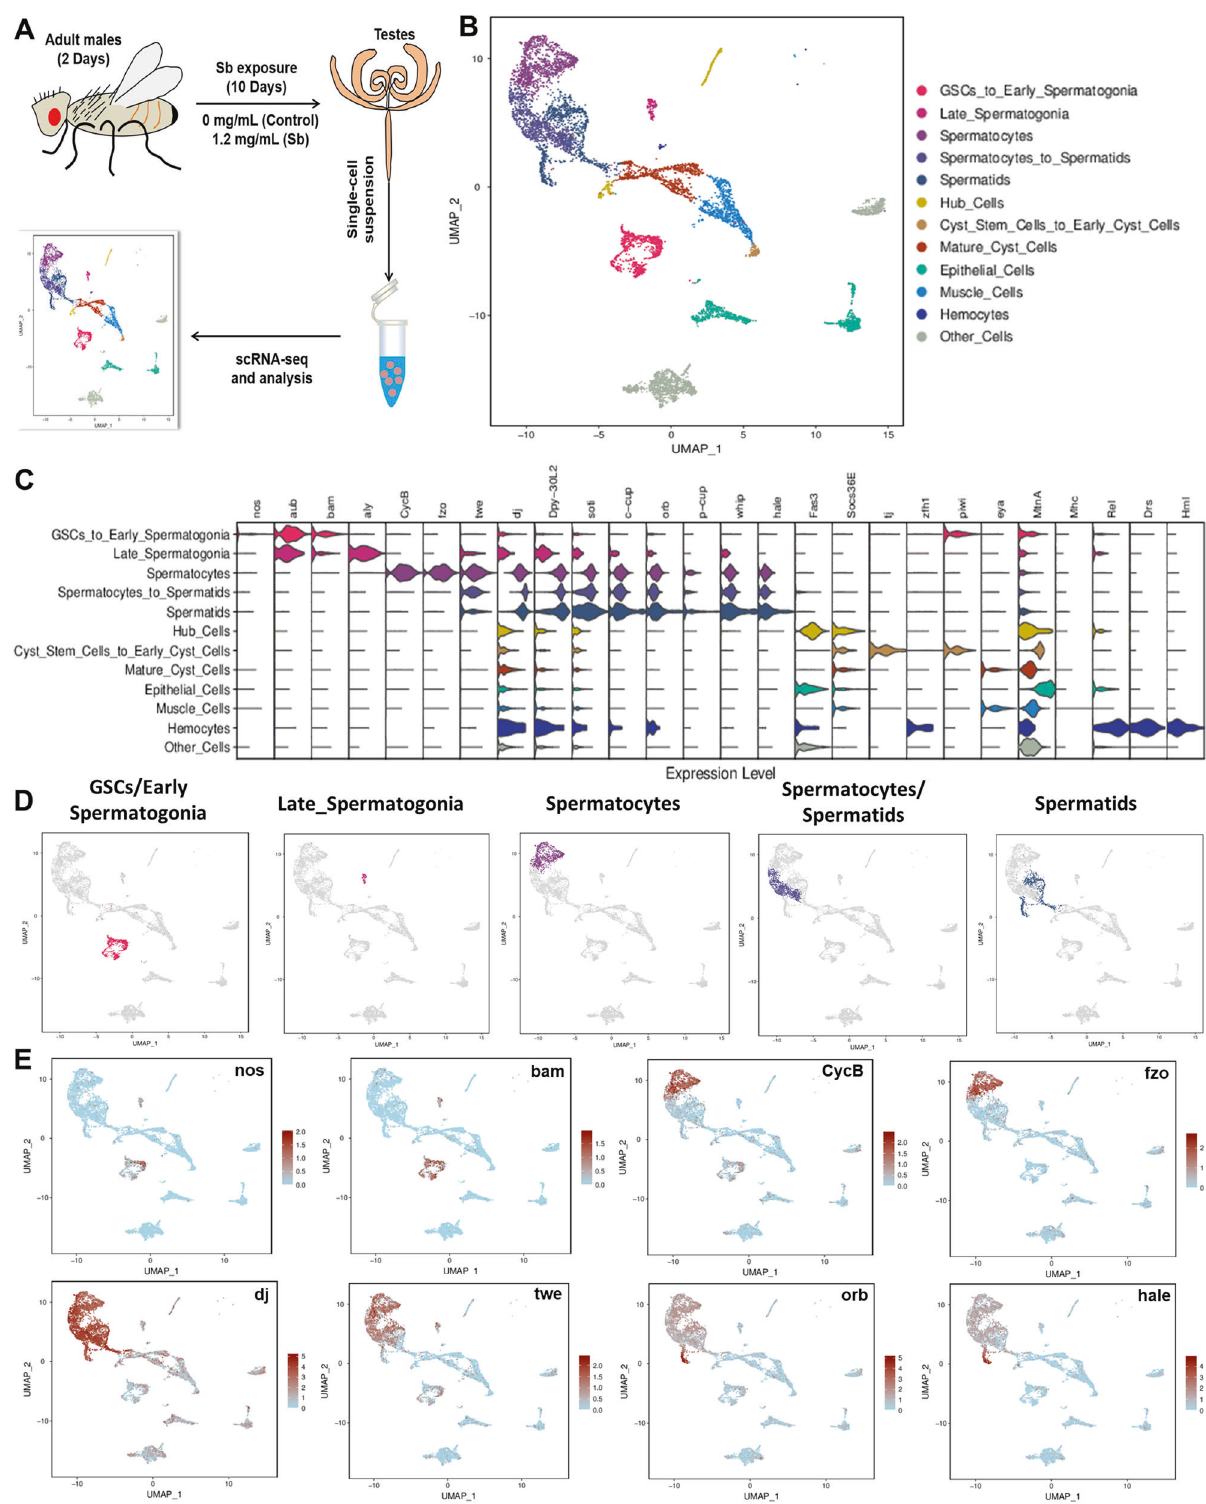
Fig. 2 Identi fi cation of testicular cell clusters by scRNA-seq. A An illustrated fl ow chart of scRNA-seq in the Drosophila testis. B Annotations of testicular cell clusters via UMAP visualization. C The violin plot views of expression patterns for marker genes in the Drosophila testis. D UMAP visualizations of germ cells at different stages. E UMAP visualizations of representative marker